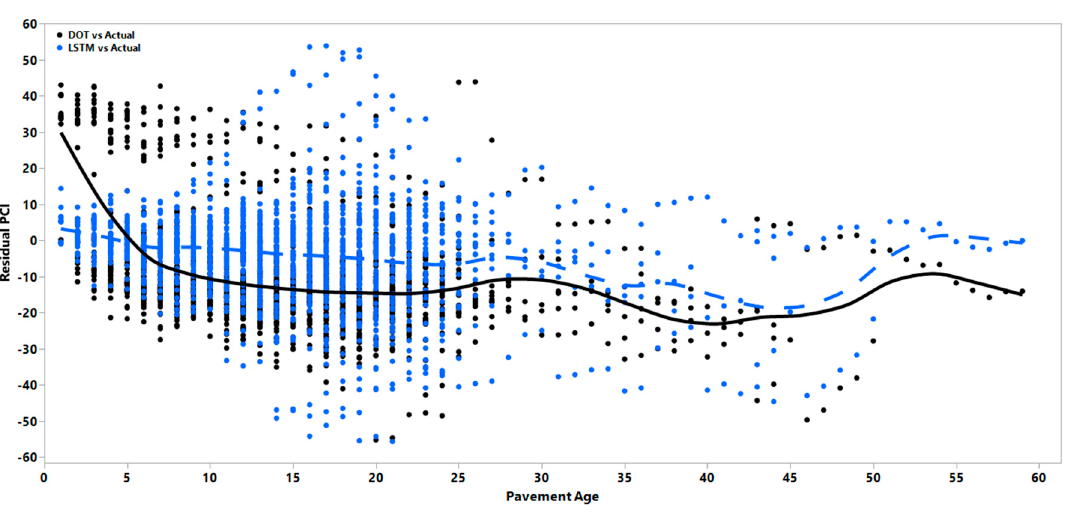
Figure 7. PCI residual vs. age in AC pavements.